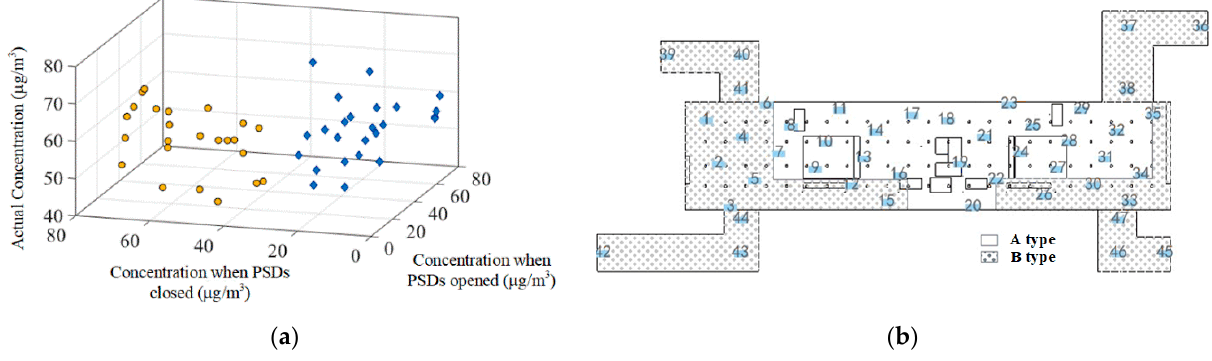
Figure 16. Cluster and spatial region classification results: ( a ) Cluster result; ( b ) Concourse floor areas corresponding to different types of sampling points.